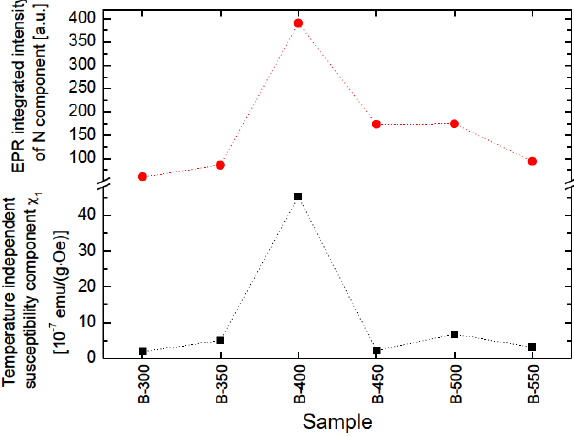
Figure 23: Correlation between the temperature independent dc susceptibility component χ 1 and the EPR integrated intensity of the N component in B-300 to B-550